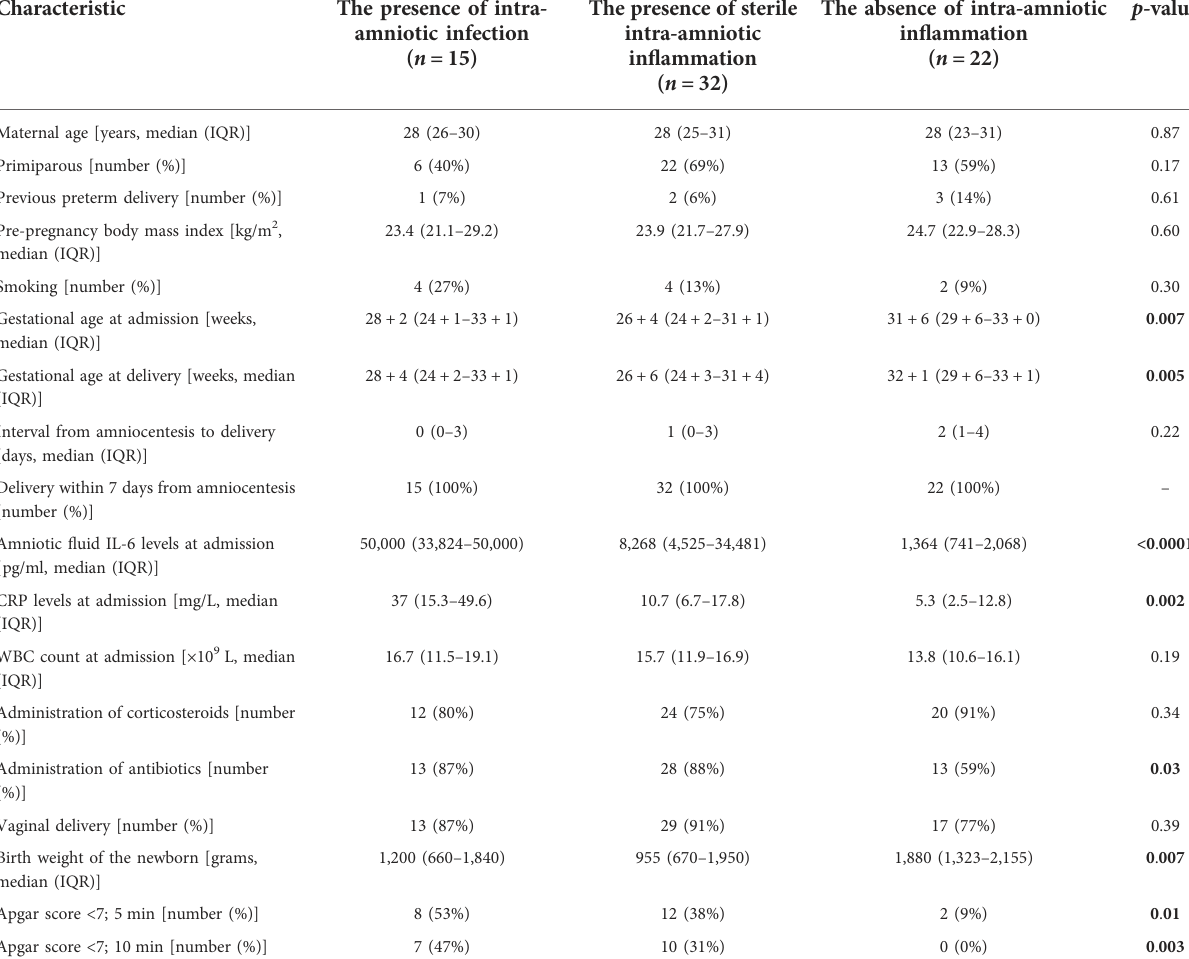
TABLE 1 Maternal and clinical characteristics of women with preterm labor with intact membranes prior to gestational age 35 weeks with respect to the presence of intra-amniotic infection, presence of sterile intra-amniotic in fl ammation, and absence of intra-amniotic in fl ammation.